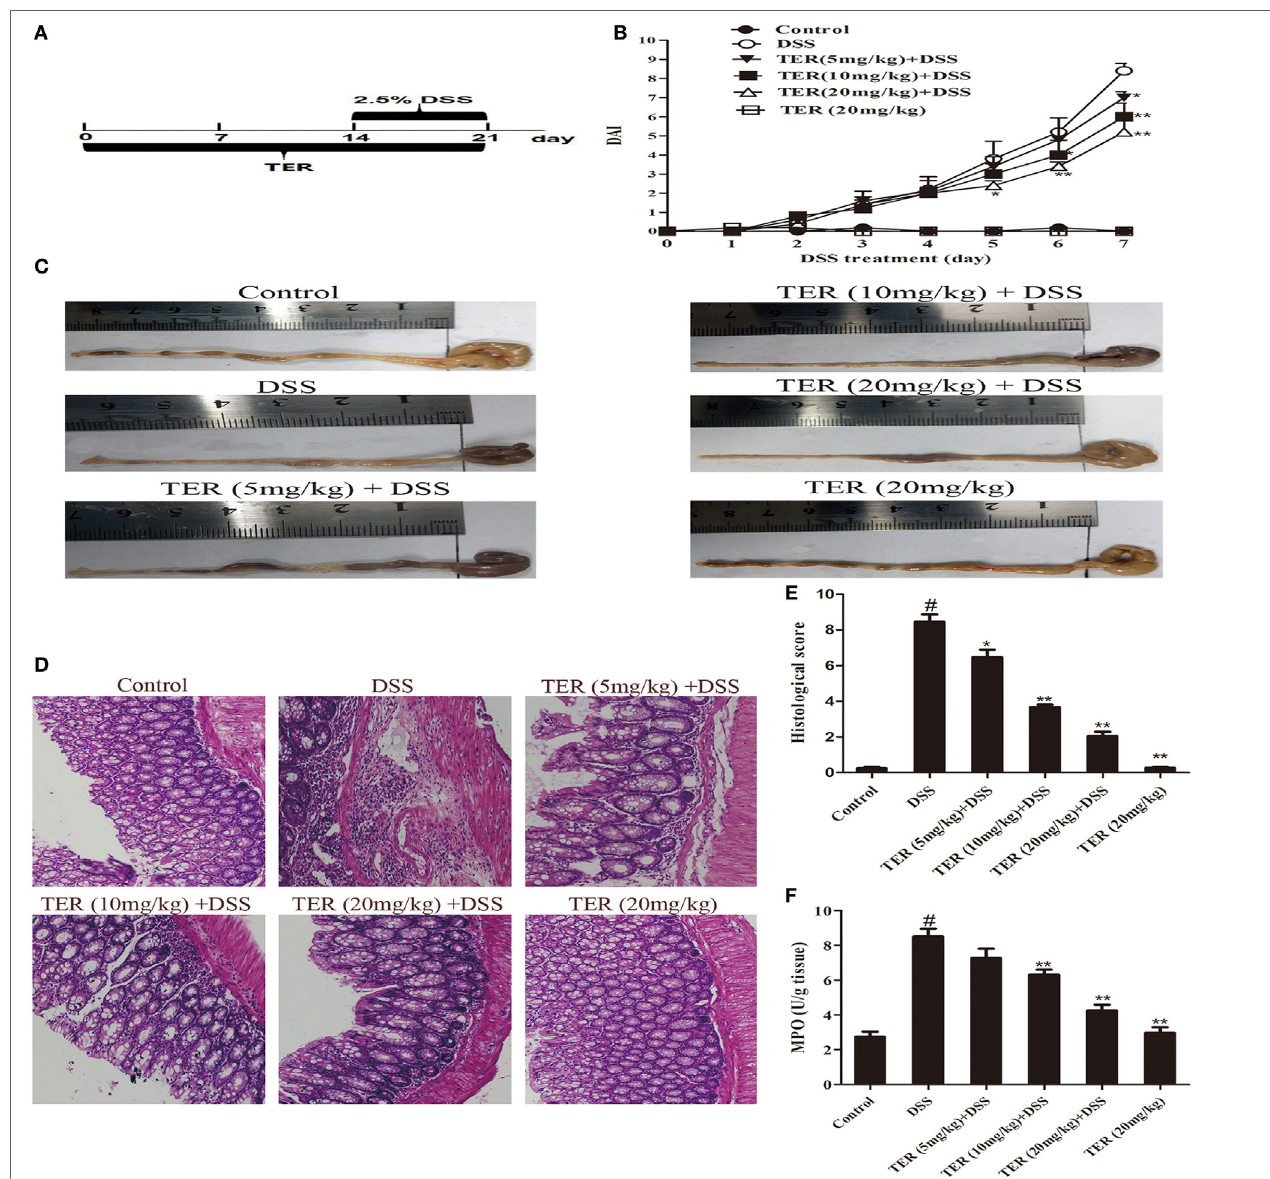
FigUre 1 | Terpinen-4-ol (Ter) attenuates dextran sulfate sodium (Dss)-induced colitis in c57Bl/6 mice . Mice were treated with 2.5% DSS in their drinking water for 7 days to induce acute colitis. TER (5, 10, 20 mg/kg) was administered for 14 days before and during DSS treatment via oral gavage once per day. Mice were sacrificed at day 21 after colitis induction. (a) The experimental protocol with TER in acute colitis model. (B) Disease activity index (DAI) during the disease process. (c) The lengths of colons from each group of mice were measured. (D) The colons from each experimental group were processed for histological evaluation (hematoxylin–eosin staining, 200 × ; scale bar, 50 µm). (e) Histopathological scores of each group were determined. (F) Myeloperoxidase (MPO) activity in the colonic tissues was detected. The results are representative of at least three independent experiments and expressed as mean ± SD. * p < 0.05 and ** p < 0.01 vs the DSS-treated group on the same day; # p < 0.05 vs the control